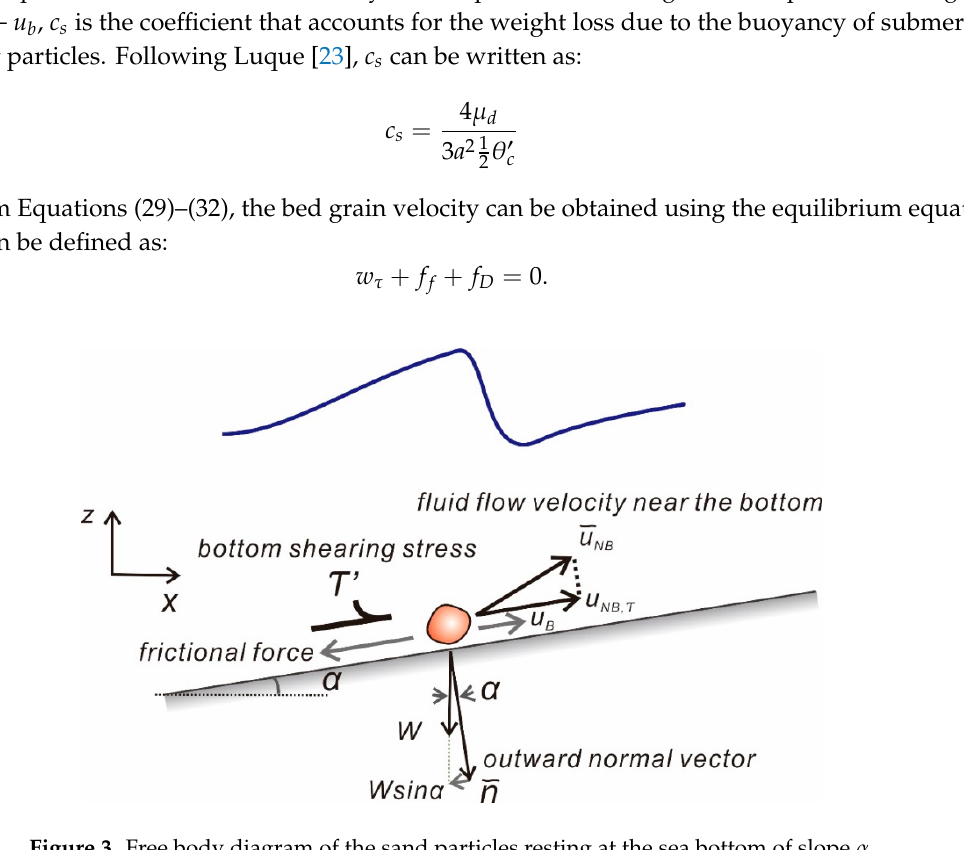
Figure 3. Free body diagram of the sand particles resting at the sea bottom of slope